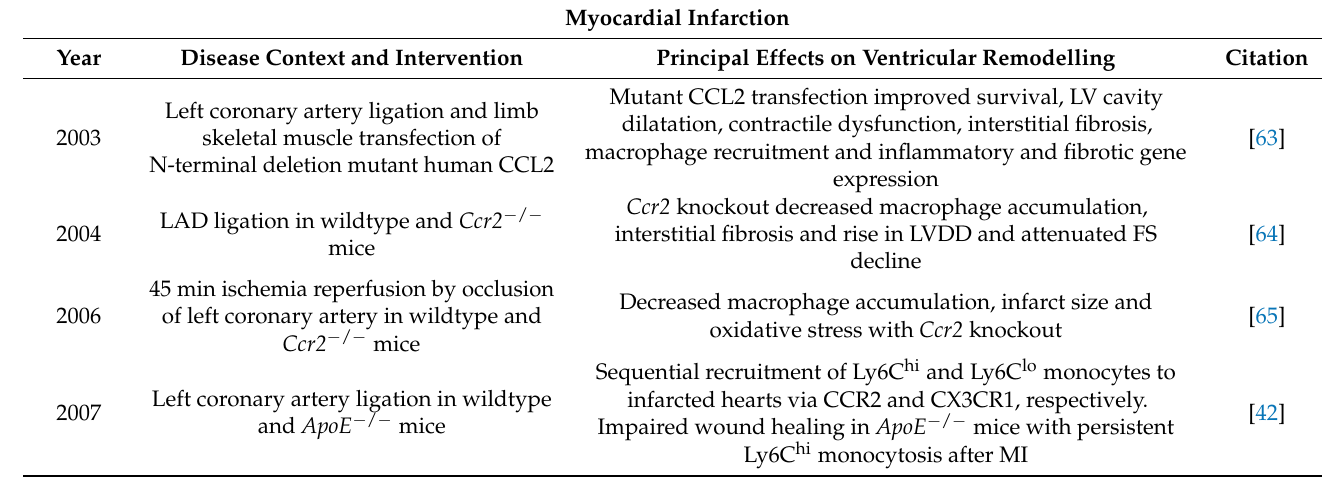
Table 1. Experimental studies reporting the roles of CCR2 + monocytes/macrophages in cardiac disease associated with ventricular